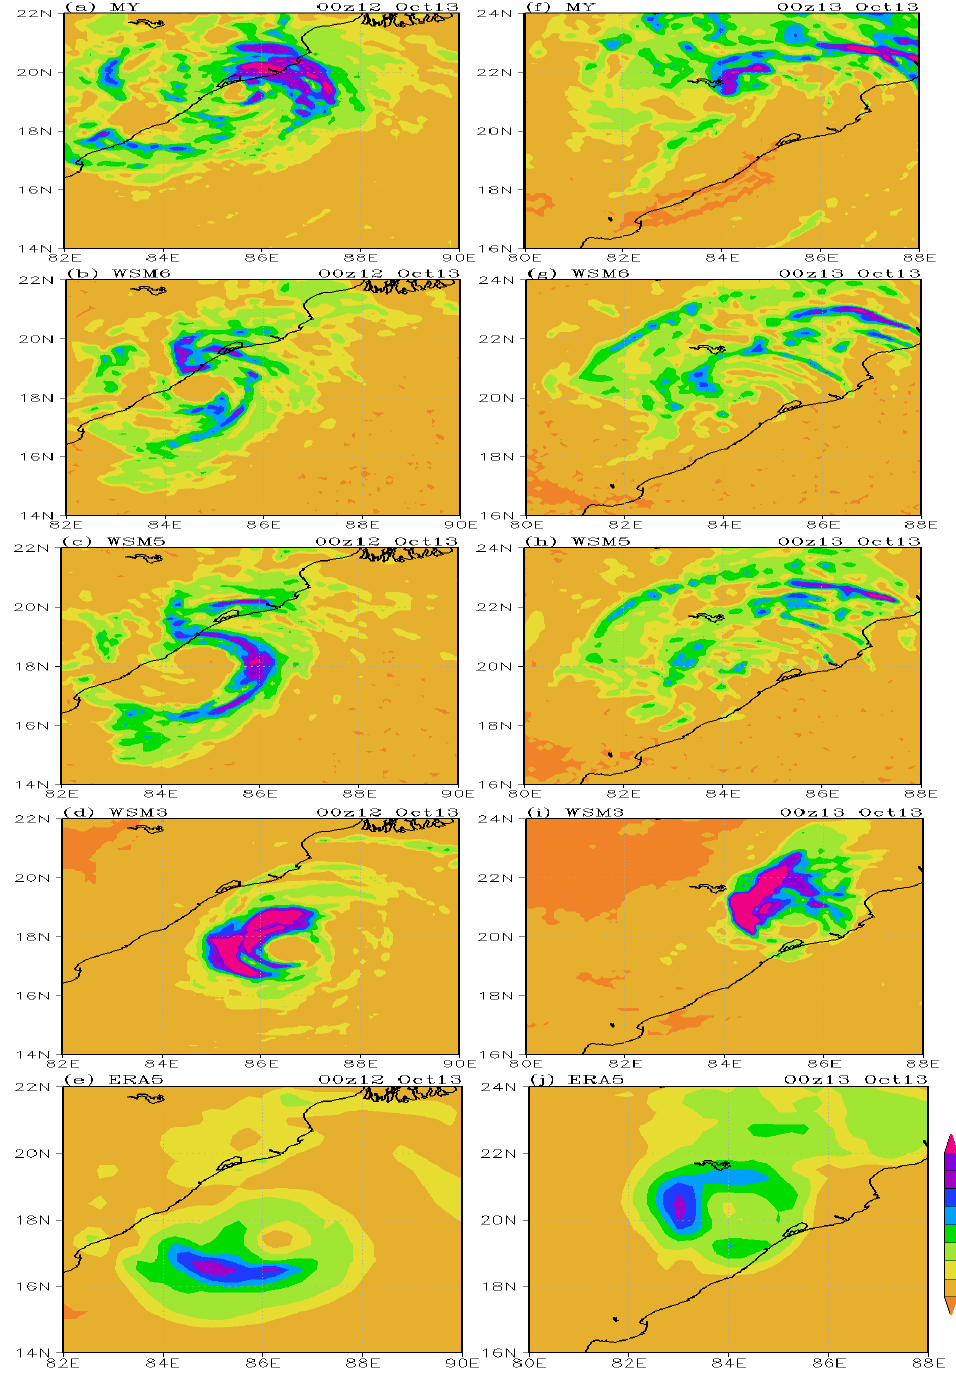
Figure 13. Horizontal distributions of average (1000–100 hPa) level precipitation hydrometeors (Qcloud and Qrain) derived from WRF ( a ) MY, ( b ) WSM6, ( c ) WSM5, and ( d ) WSM3 D02 experi- ments and ( e ) ERA5 reanalysis during the ESCS stage of Phailin valid at 00 UTC, 12 October 2013. Distributions in ( f – j ) are the same as ( a – e ), but valid at 00 UTC, 13 October 2013.